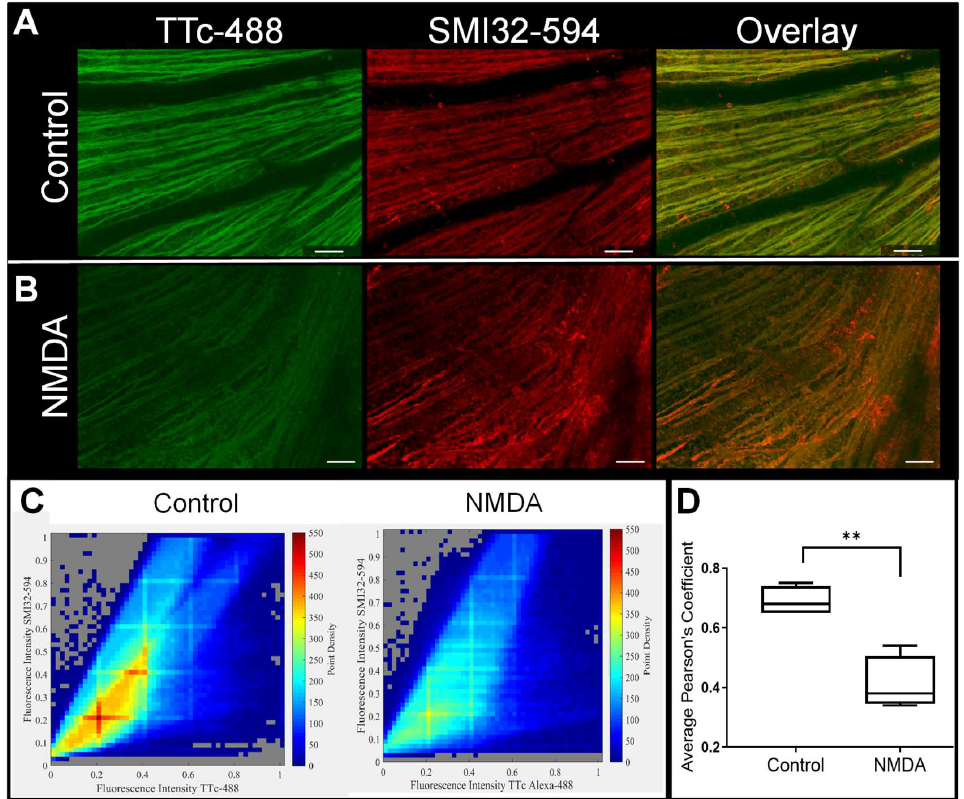
Figure 4. Morphological and structural changes in the retinas of NMDA-treated eyes. ( A ) The en face confocal view of control RAs show the highly organized radial lines of TTc-488 and SMI32-labeled neurofilaments in the RAs, with the retinal vasculature visible as dark undulations etched over this background. ( B ) The NMDA-treated eyes presented with reduced fluorescent intensity of TTc-488 and